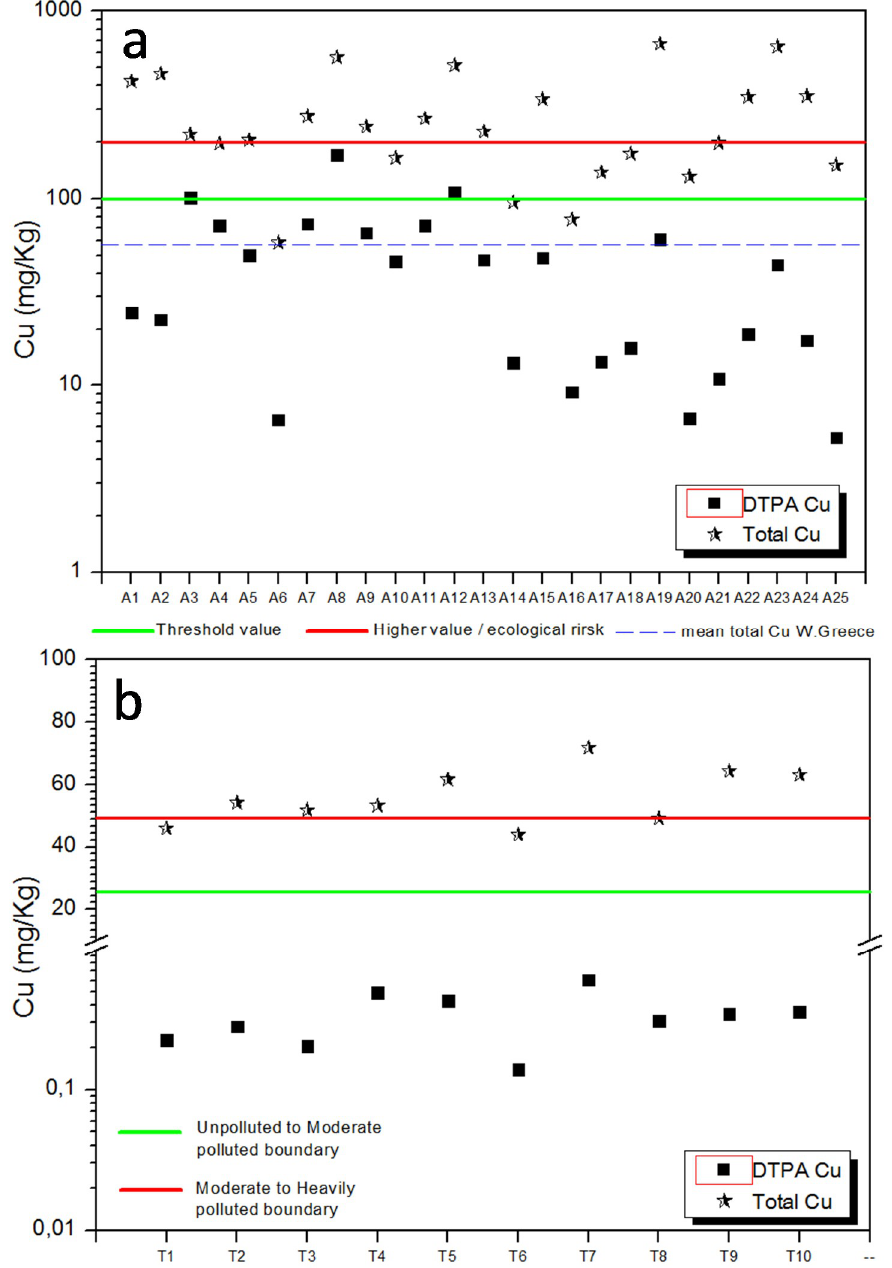
Figure 5. ( a ) Total and DTPA Cu values for the Aetoliko olive orchard soil samples in relation with the threshold, the higher ecological risk and the mean value reported for Western Greece and ( b ) total and DTPA Cu values for the Aetoliko lagoon sediment samples in relation to the Sediment Quality Guideline values of US EPA.